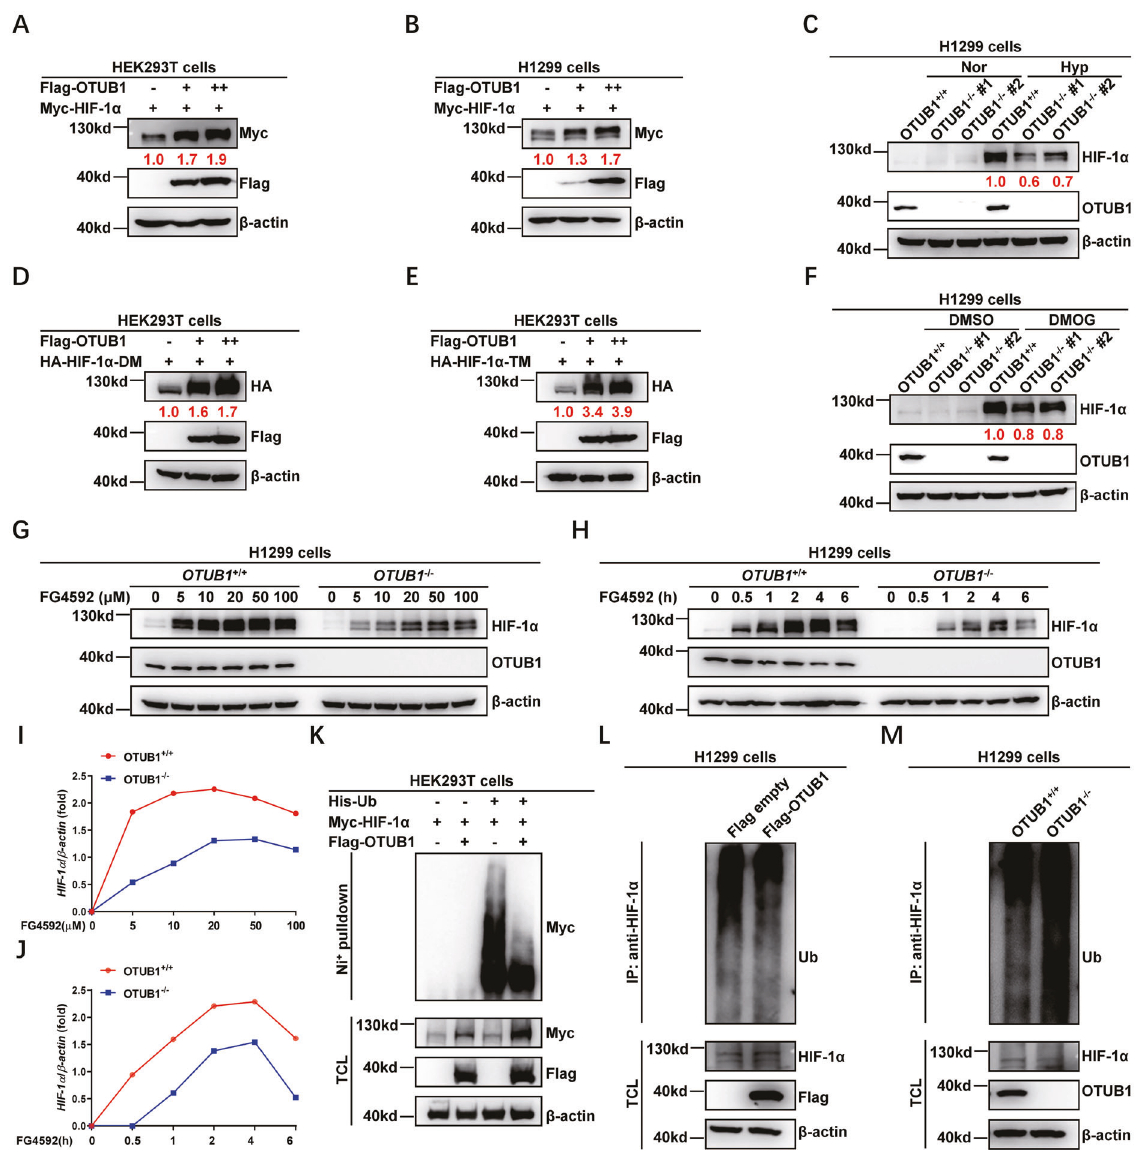
(Fig. 7A – D). In addition, the correlation of expression of OTUB1 and GLUT1, LDHA or PGK1 was validated (Figs. 7E, S8A, B). Consistently, OTUB1 -de fi cient H1299 cells ( OTUB1 − / − ) proliferated much slower than OTUB1 -intact H1299 cells ( OTUB1 + / + ) (Fig. 7F –